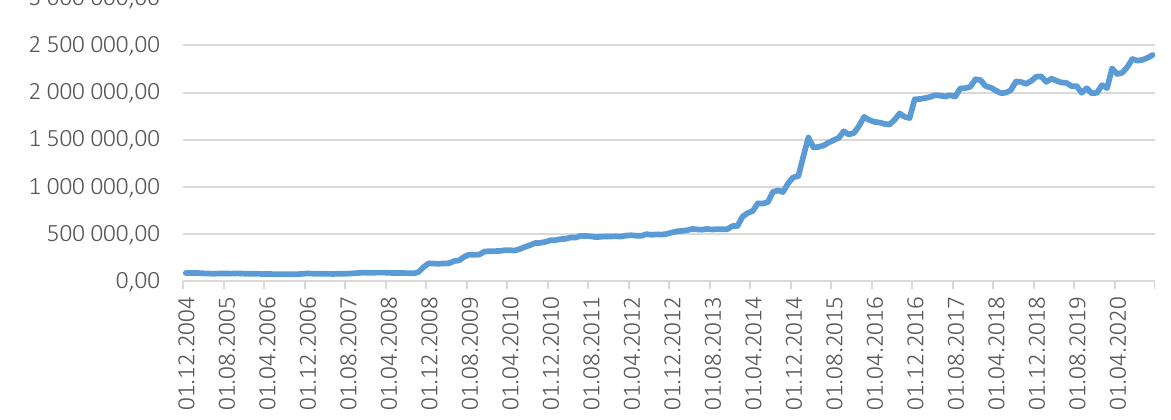
Figure 1. Time series graph of the State Debt of Ukraine 2004–2020, UAH